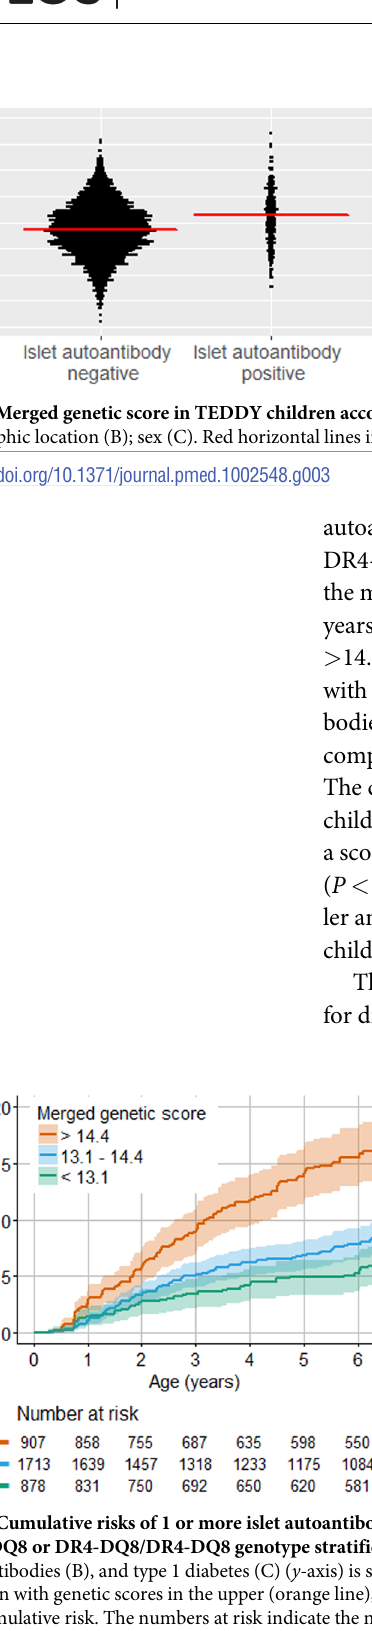
PLOS Medicine| https://doi.org/10.1371/journal.pmed.1002548 April 3,